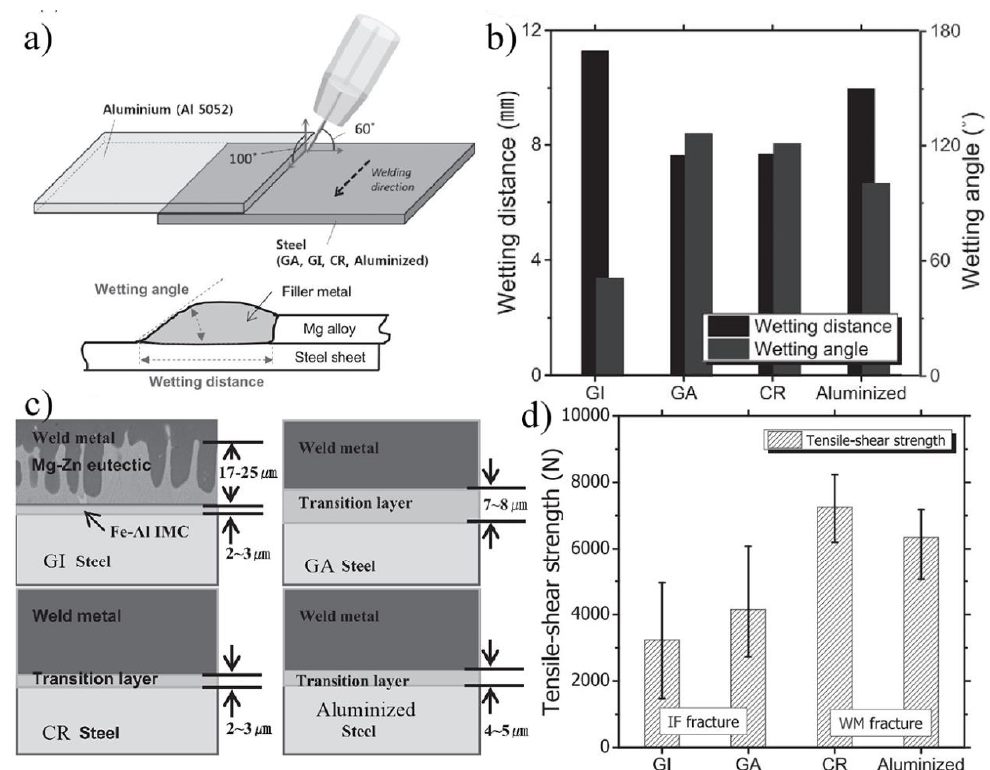
Figure 18. CMT lapped Mg-to-steel sheet welding process [62] ( a ) schematic diagram; ( b ) measured wetting angle and distance; ( c ) schematic of the transition layer; ( d ) tensile shear strength of the four types of brazed joints.